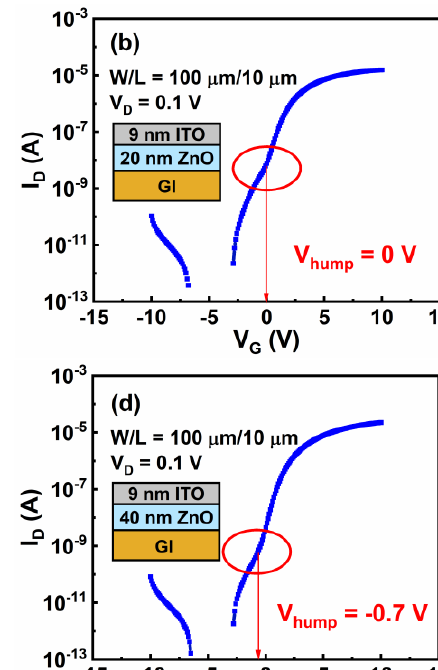
− 3.0 Figure 7. I D – V G curves for group B TFTs. The t ITO values are ( a ) 3 nm, ( b ) 5 nm, ( c ) 7 nm, and ( d ) 9 nm. The t ZnO value is 25 nm.